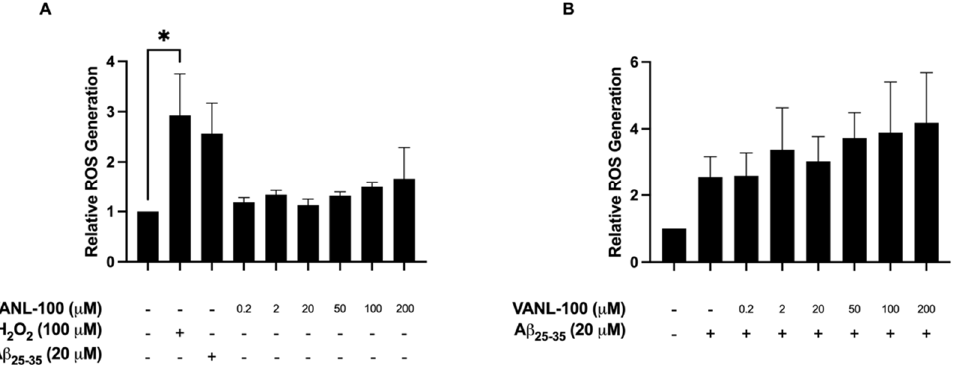
Figure 8. Effect of VANL-100 treatment on ROS generation in SH-SY5Y cells. Relative ROS generation is shown on the y-axis, and individual treatments are displayed on the x-axis. The bars represent the mean ± SEM of four independent experiments. ( A ) Effect of H 2 O 2 , A β 25–35 , and VANL-100 alone on ROS production. ( B ) Effect of A β 25–35 alone and VANL-100 with A β 25–35 on ROS production. Statistical significance was assessed using one-way ANOVA. * p < 0.05.